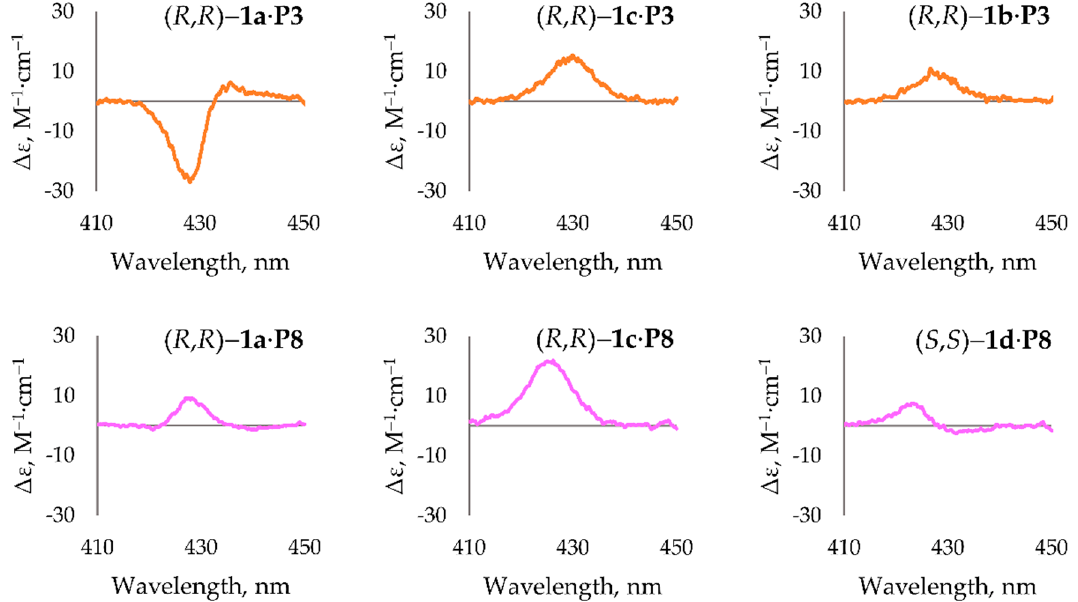
Figure 7. Representative experimental CD spectra obtained for the complexes of thioureas 1a–d with zinc porphyrins P3 and P8 (CH 2 Cl 2 , 293 K). The complete CD spectral data for all studied host–guest pairs is provided in the Supplementary Materials.